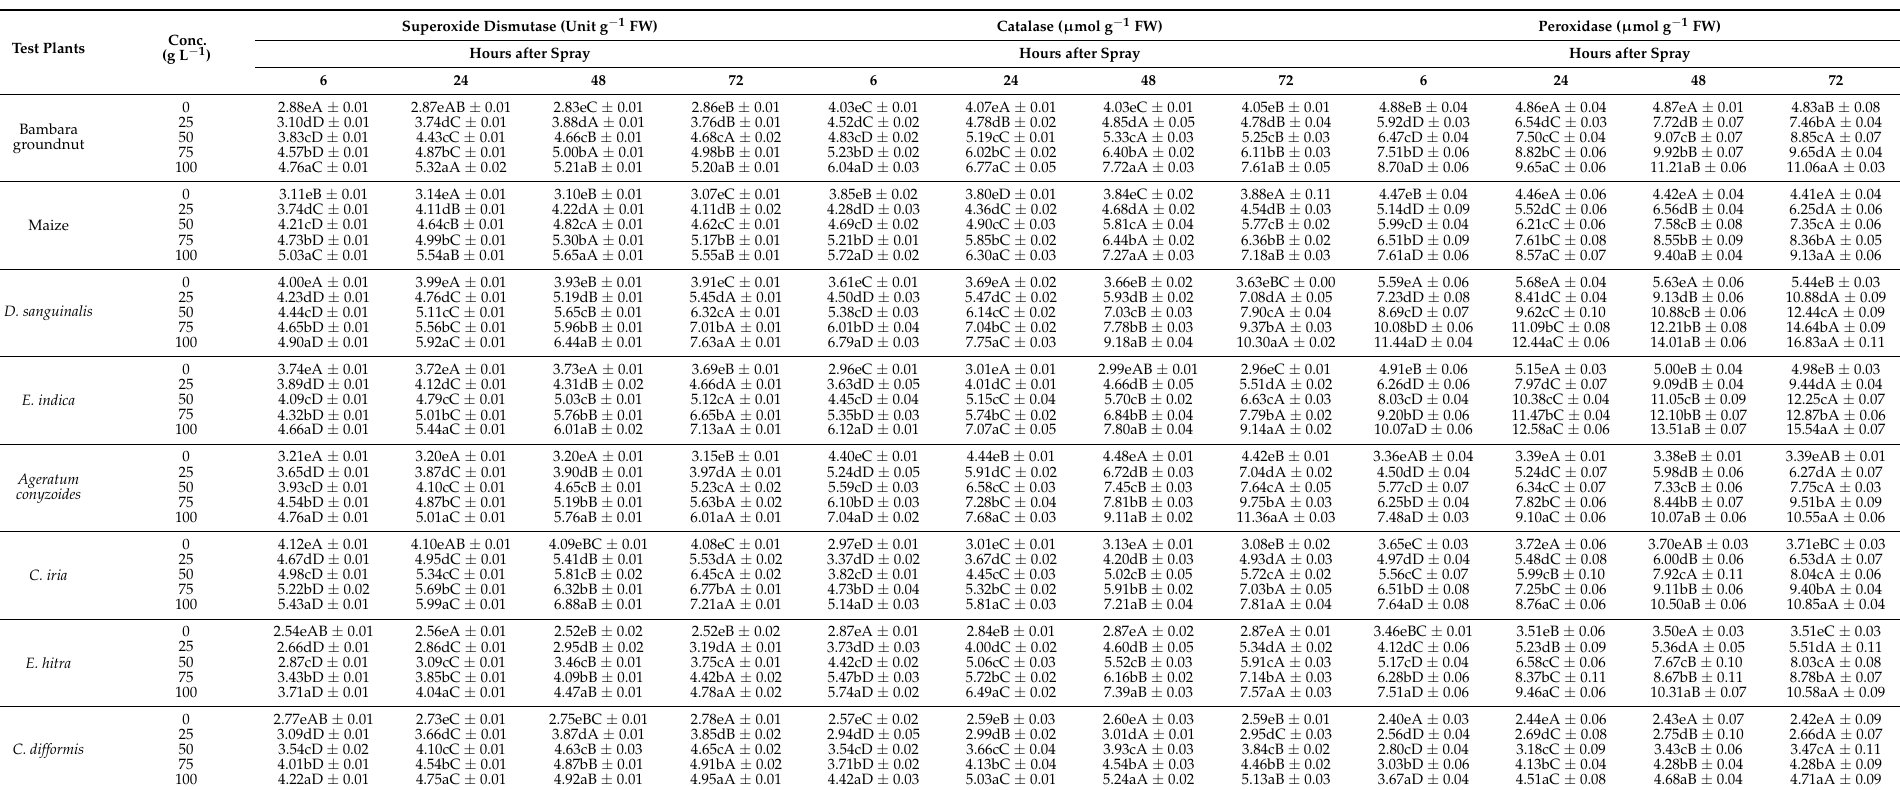
Table 7. Response of superoxide dismutase, catalase, and peroxidase activity of some crops and weeds due to the foliar spray of P. hysterophorus leaf methanolic extract.